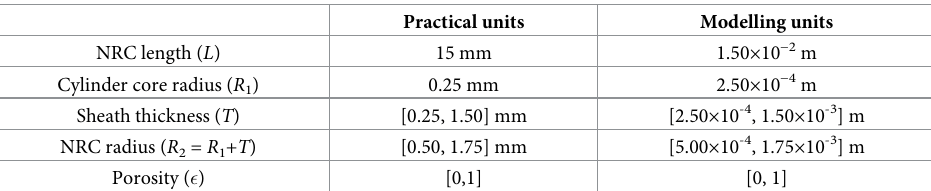
Table 2. NRC geometry